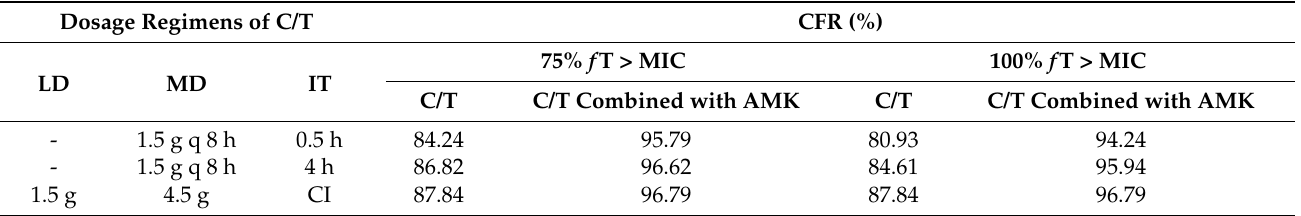
Table 6. The cumulative fraction of response (CFR) for each dosing regimen of ceftolozane/tazobactam (C/T) and ceftolozane/tazobactam (C/T), combined with amikacin (AMK).